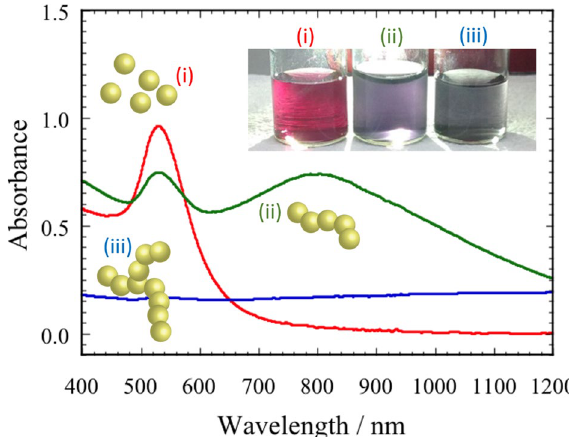
Figure 2. Typical absorption spectra of Au nanoparticles: (i) dispersed structure, (ii) chain-like structure, and (iii) precipitated aggregates structure with a branch